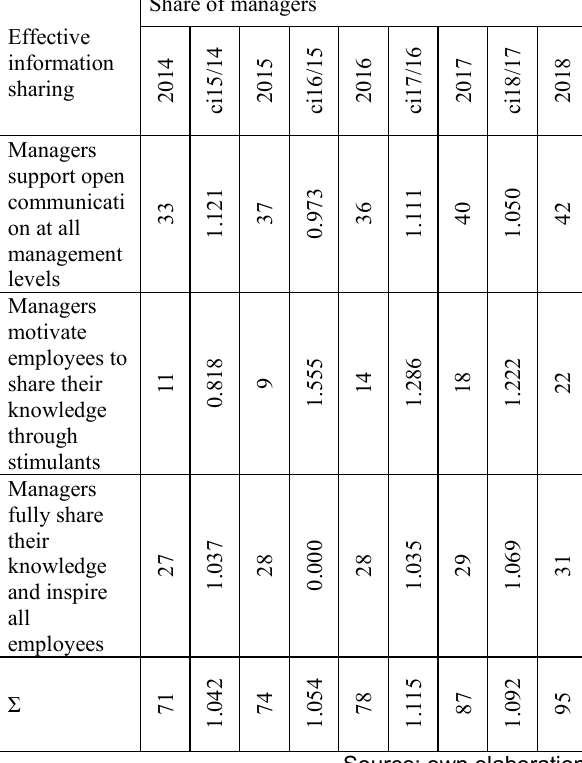
Table 3. Chain Index of Changes - Strategic Approach to Human Resources Development